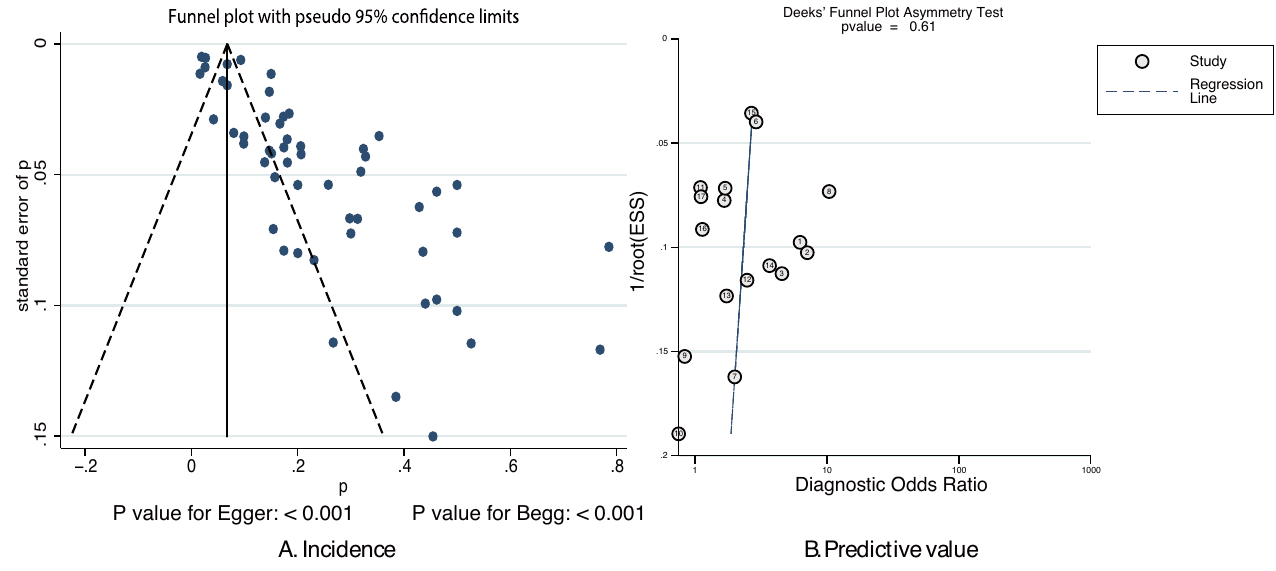
Deeks’ Funnel Plot Asymmetry Test pvalue = 0.61